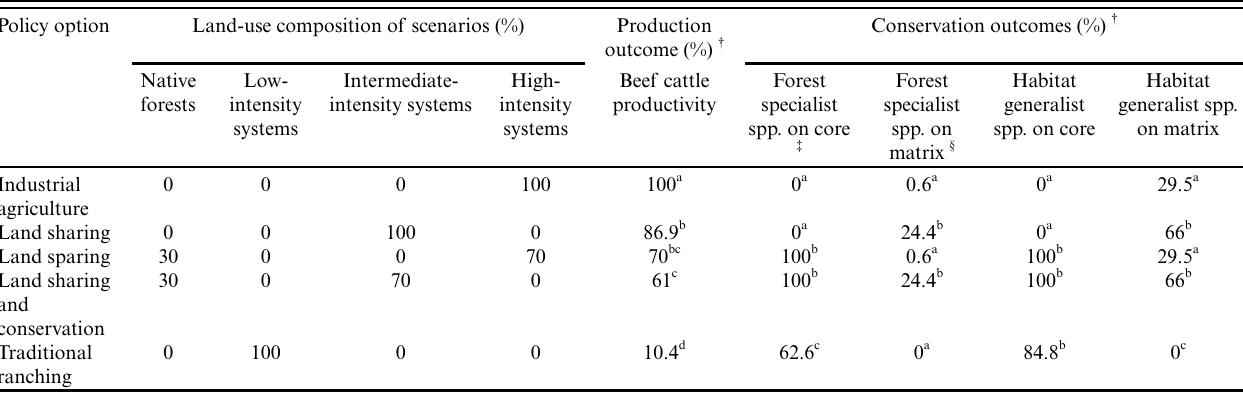
Table 2 . Production and conservation outcomes achieved under alternative land-use policy